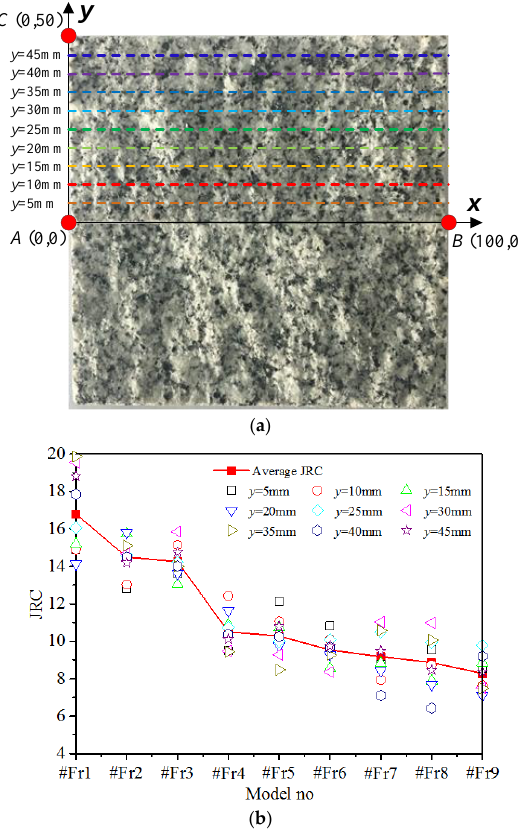
Figure 4. ( a ) Z 2 values calculation, and ( b ) JRC values distribution of the tested